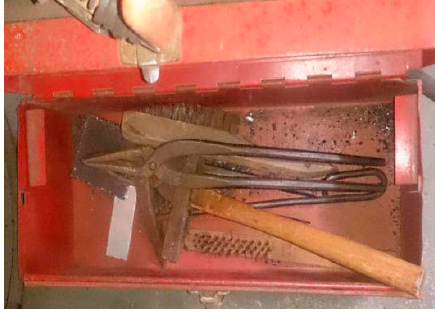
Figure 5. Wearing Safety Protective Gear for Welding.